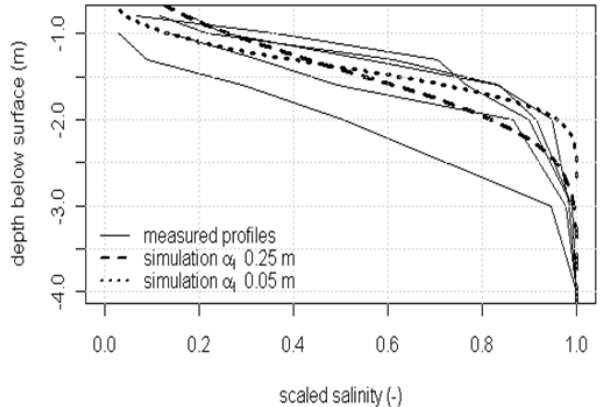
Fig. A1. Profiles of salinity as a function of depth for thin lenses. Numerical simulations with different dispersivities are compared to several representative soil profiles measured on two field sites on the island of Schouwen-Duiveland, The